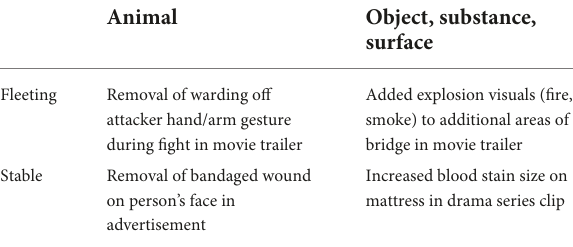
TABLE 2 Change detection task